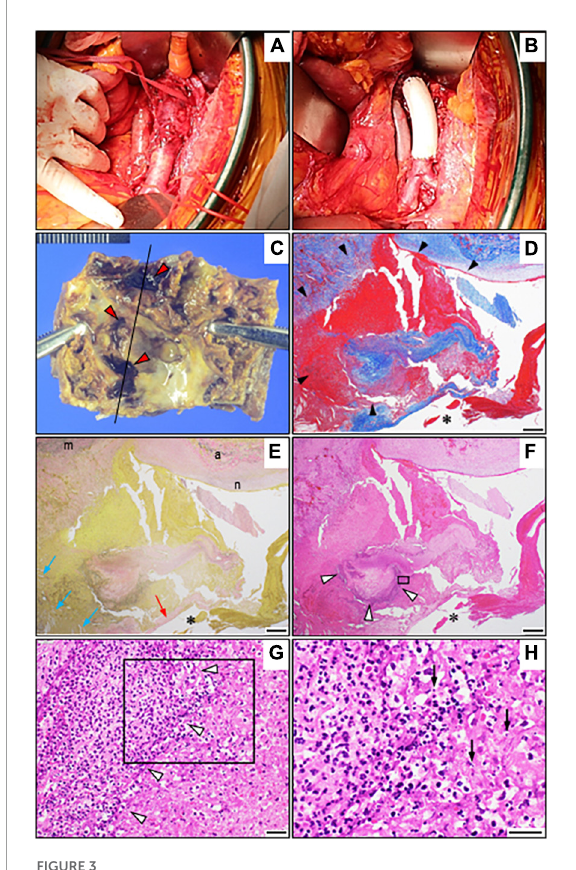
FIGURE3 Operative view and pathological findings. (A,B) Intraoperative view before (A) and after (B) the repair using a Dacron graft. (C) The resected abdominal aortic aneurysm shows severely calcified plaque as well as several recesses with adherent mural thrombi (red arrowheads). (D–F) Photomicrographs of the resected abdominal aorta (longitudinal sections around the black line in C ) with Masson’s trichrome stain (D) , Elastica van Gieson staining (E) , and hematoxylin and eosin staining (F) showing marked inflammatory infiltration of the aortic wall (white arrowheads) and pseudoaneurysm formation (black arrowheads) due to loss of the normal structure of the aortic wall as well as cholesterol crystals (blue arrows). (G) A high-power view with hematoxylin and eosin staining showing intense perivascular inflammatory infiltrates (magnified view of the black box in F ) but no microorganisms (white arrowheads). (H) Notably, the magnified view of the black box in (G) shows the accumulation of nuclear debris (arrows). Bars: (D–F) , 500 µ m; and (G,H) , 20 µ m. *Vascular lumen. The red arrow depicts a fibrous cap, while “m,” “a,” and “n” depict the media, adventitia, and neointima,